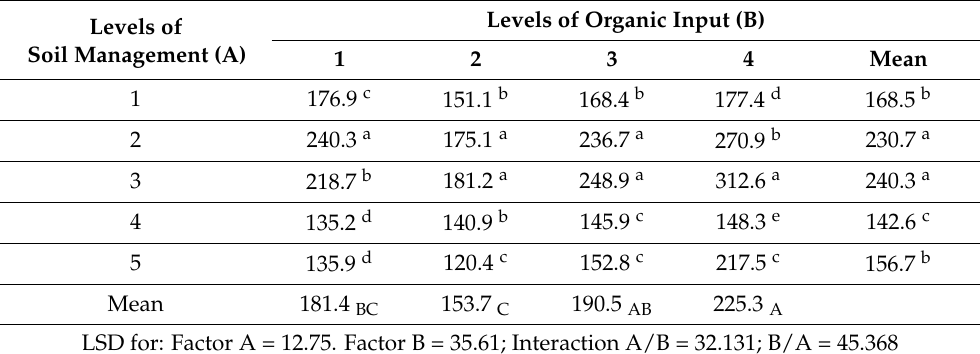
Table 3. Phytosanitary index of the soil depending on the tillage method (factor A) and stubble management (factor B) in the short-term monoculture of winter wheat. Levels